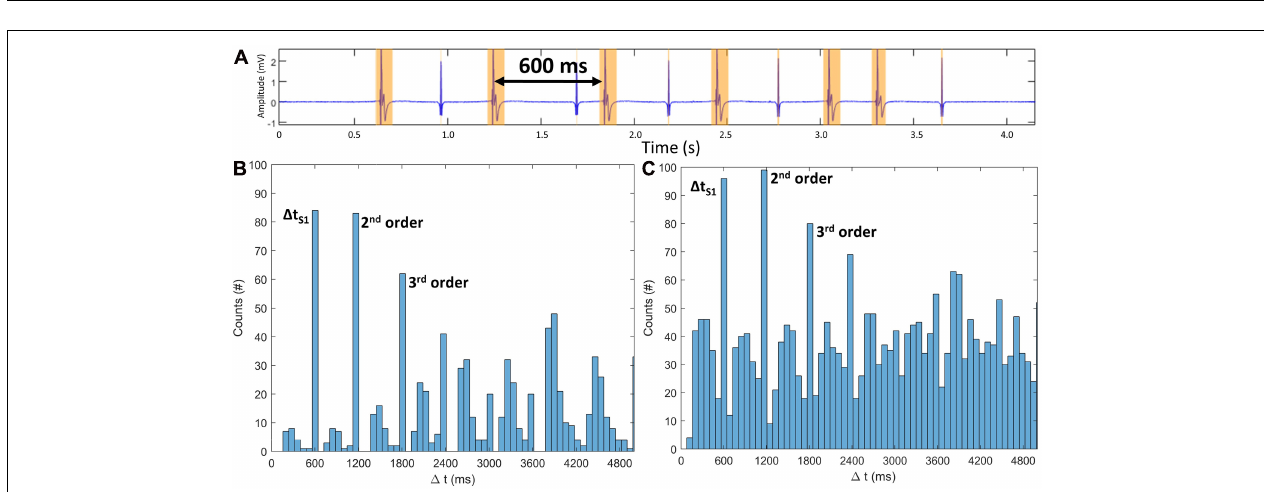
FIGURE 1 | Segmentation pipeline for clinical S1S2 protocol measurements consisting of EGM, ECG, and geometry data. Gray boxes are pipeline input. The pipeline yields segmented atrial activities. In additional steps, CV and amplitude restitution can be calculated.